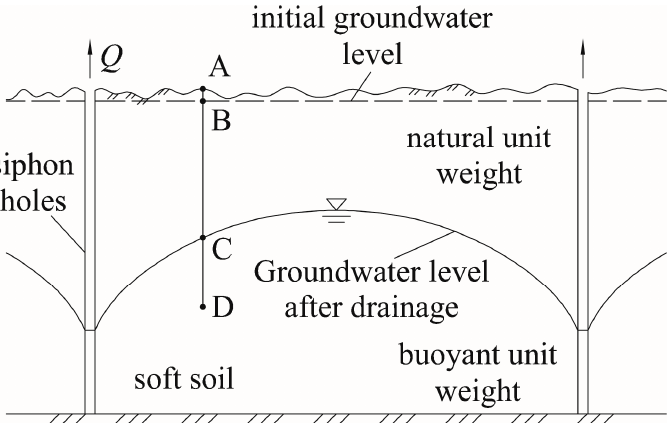
Figure 1. Diagram of groundwater level in soil mass before and after siphon drainage (Point A is at the surface, point B is at the initial groundwater level, point C is at the groundwater level after drainage, and point D is below the groundwater level after drainage).